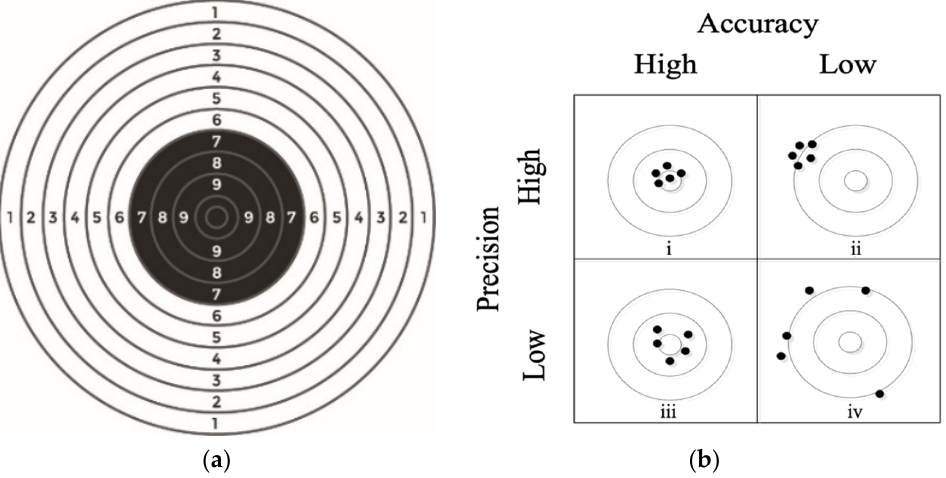
Figure 2. ( a ) Standardized pistol target; ( b ) the distribution of accuracy and precision: (i) high accuracy and high precision, (ii) low accuracy but high precision, (iii) low precision but high accuracy, (iv) low accuracy and low precision.